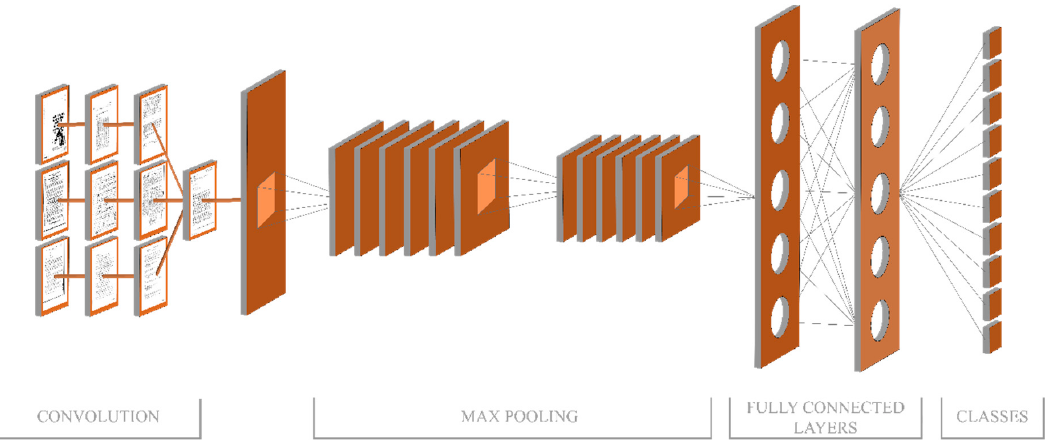
Figure 3. Structure of AlexNet Model.